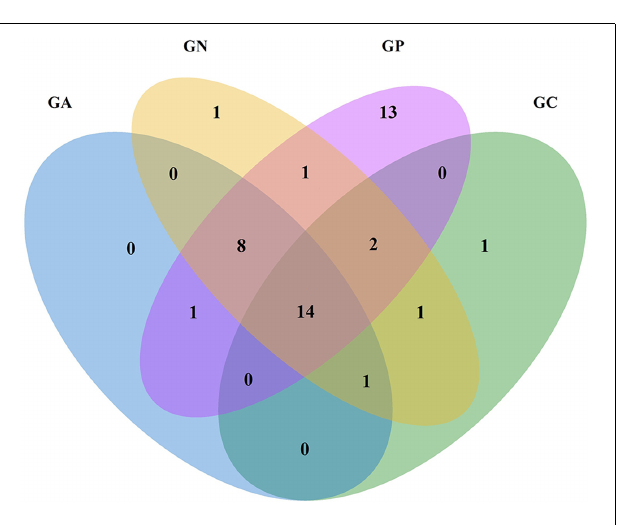
growth performances of rabbits are retarded by the